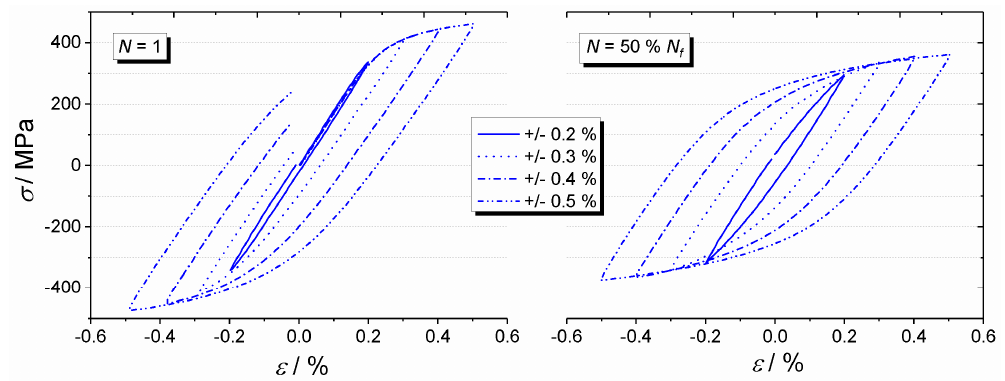
Figure 7. Evolution of the hysteresis loops at 500 ◦ C and different total strain ranges in first cycle ( left ) and at half-lifetime ( right